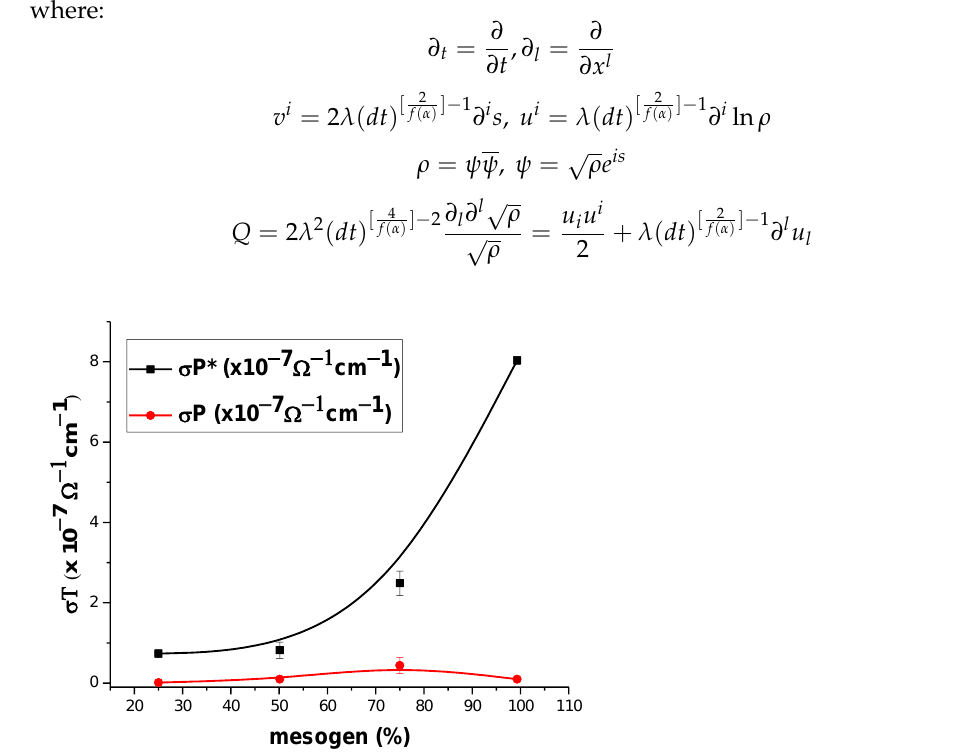
Figure 4. Graphical representation of the electrical conductivity versus percent of azomethine mesogens of polymers for untreated (P) and treated (P*) films.